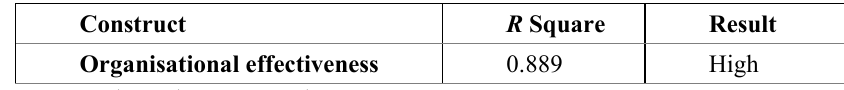
Table 4. Coefficient of Determination R Squared of the Endogenous